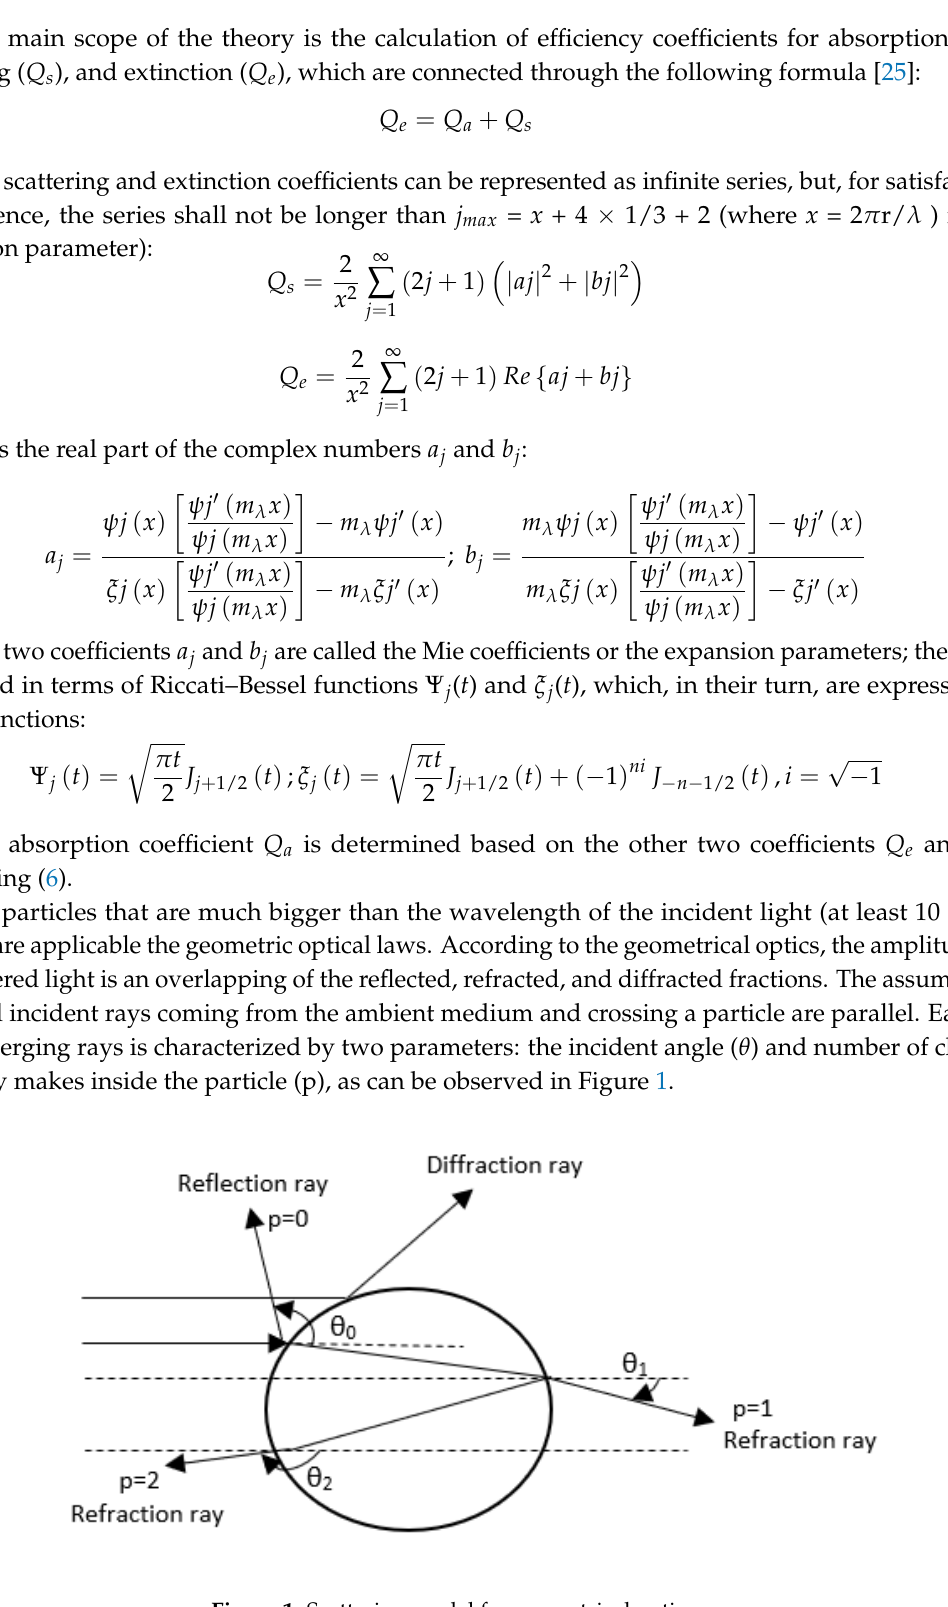
Figure 1. Scattering model for geometrical